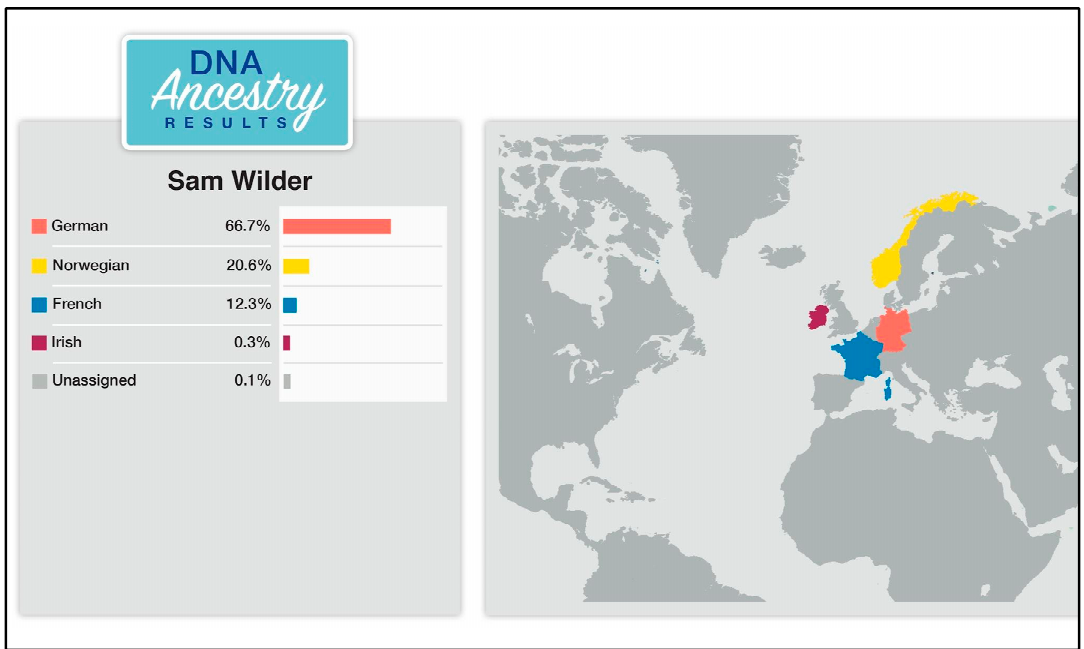
Figure 1. Example of the ancestry results printout that participants viewed and discussed in the